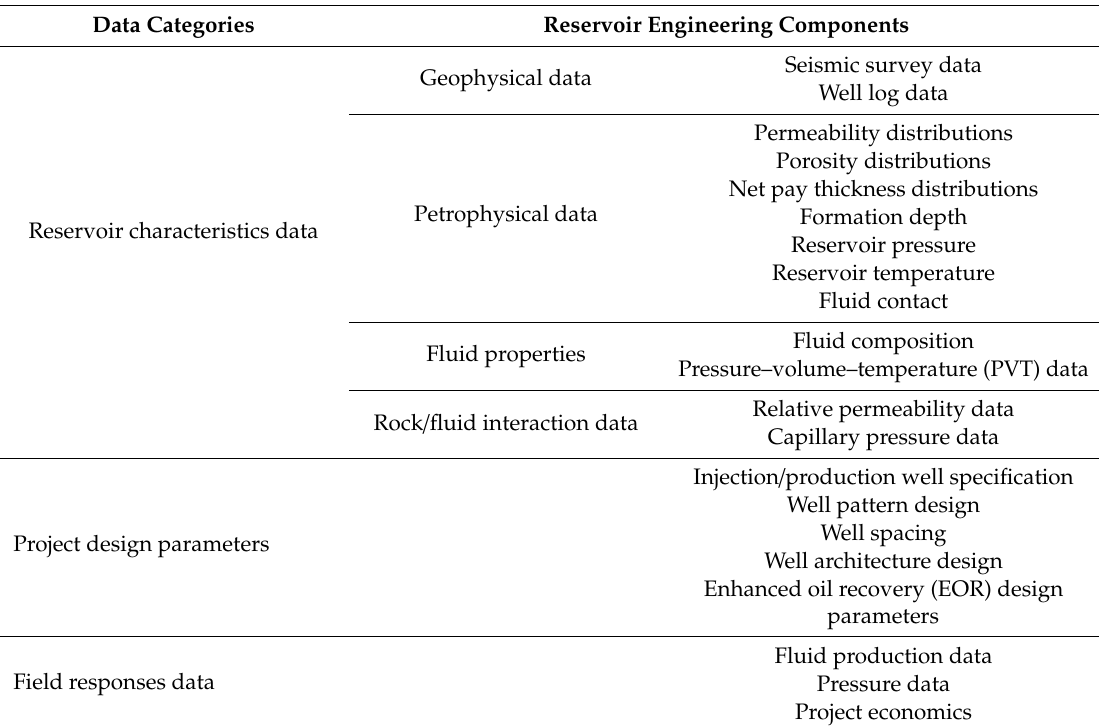
Table 1. Typical data categories considered in reservoir engineering